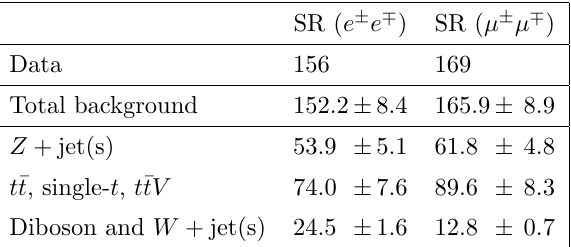
Table 6 . Numbers of expected background events in signal regions after the background-only (cid:12)t in the opposite-charge channel, compared to the data. The quoted uncertainties correspond to the total uncertainty in the predicted event yield including correlations between the various sources of systematic uncertainties. Due to rounding the total background can di(cid:11)er from the sums of components. Top-quark and Z + jet(s) yields are (cid:13)oating in the (cid:12)t.